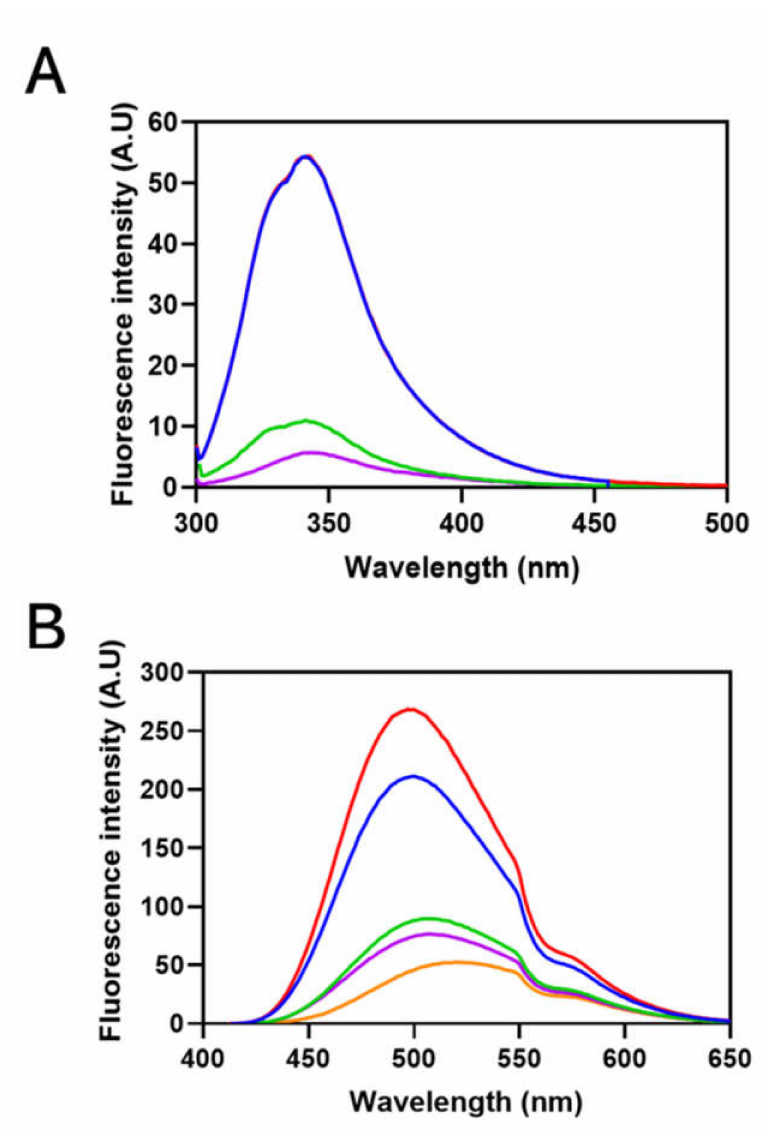
Figure 5. Fluorescence spectroscopy of the ligandin activity of Sbh26GST towards ANS, ART, PZQ, and BSP. ( A ) Intrinsic tryptophan fluorescence emission spectra of 10 µ M Sbh26GST in 50 mM Tris- HCl, pH 7, 1 mM EDTA, and 1 mM DTT with bound 1 mM GSH ( blue ), was excited at 295 nm. The effects of ligands on the spectrum were evaluated by adding 100 µ M of BSP ( purple ), ART ( green ), and PZQ ( red ) separately. ( B ) Extrinsic ANS binding fluorescence emission spectra of Sbh26GST. A 10 µ M Sbh26GST in 50 mM Tris-HCl, pH 7, 1 mM EDTA, and 1 mM DTT with bound 1 mM GSH was excited at 395 nm in the presence of 200 µ M ANS as well as various ligands. The orange line represents free ANS which was compared to ANS bound Sbh26GST ( blue ) in the presence of BSP ( purple ), ART ( green ), and PZQ ( red )